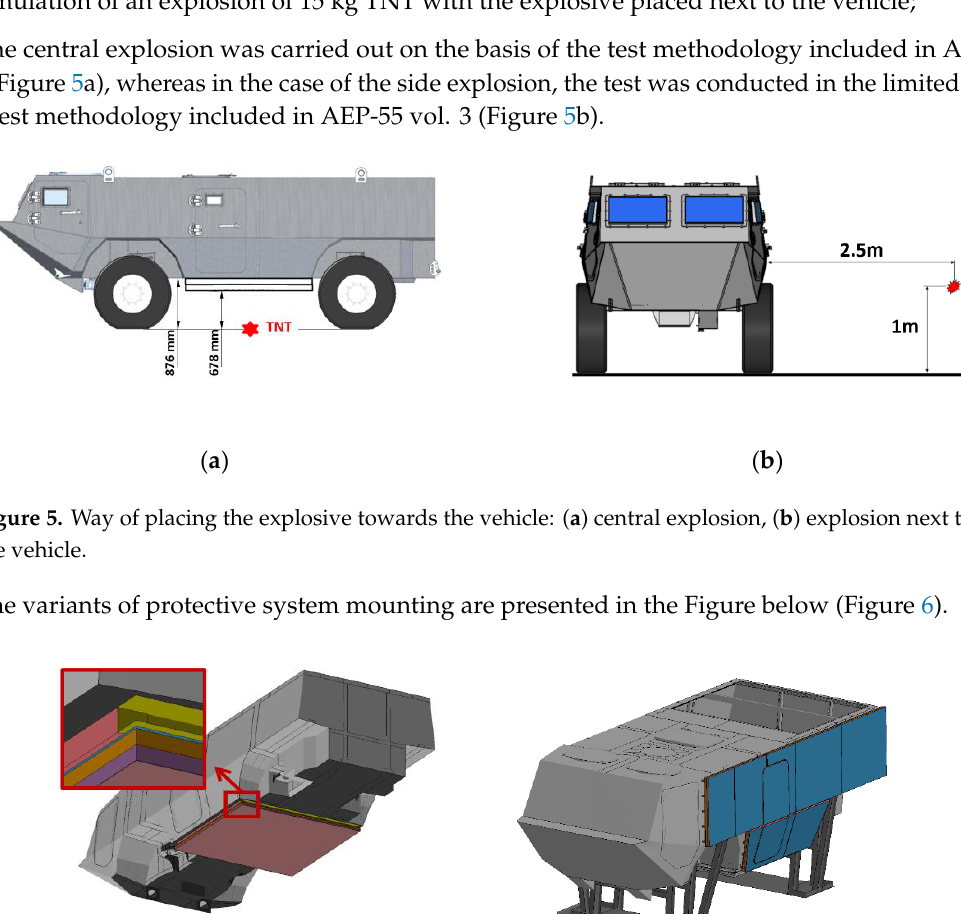
Table 1. Number of elements in numerical models. Variant with the Protective Panel